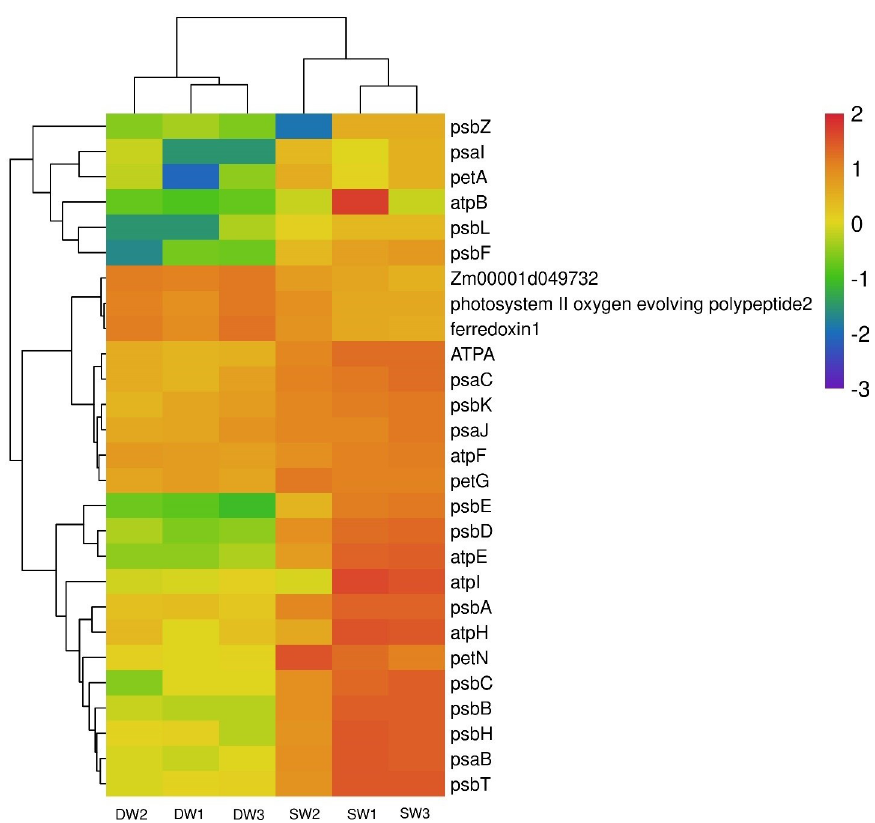
Fig 5. Heat map of photosynthesis pathway gene expression. SW refers to stable soil moisture content treatment, DW refers to alternately dry and wet treatment, and the number after that indicates the sample number.